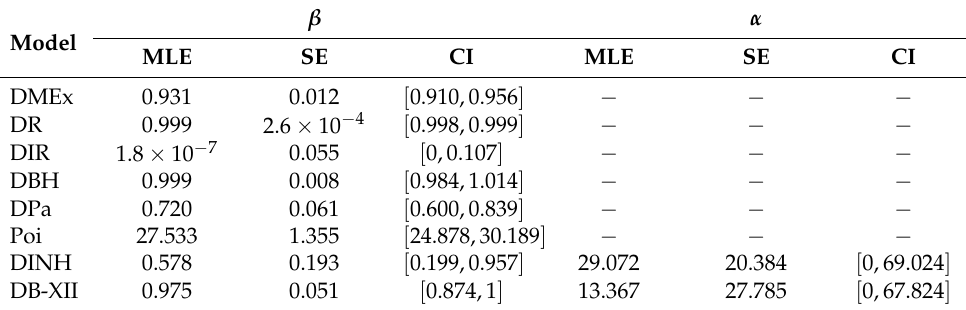
Table 6. The MLE, SE, and CI for EC data.